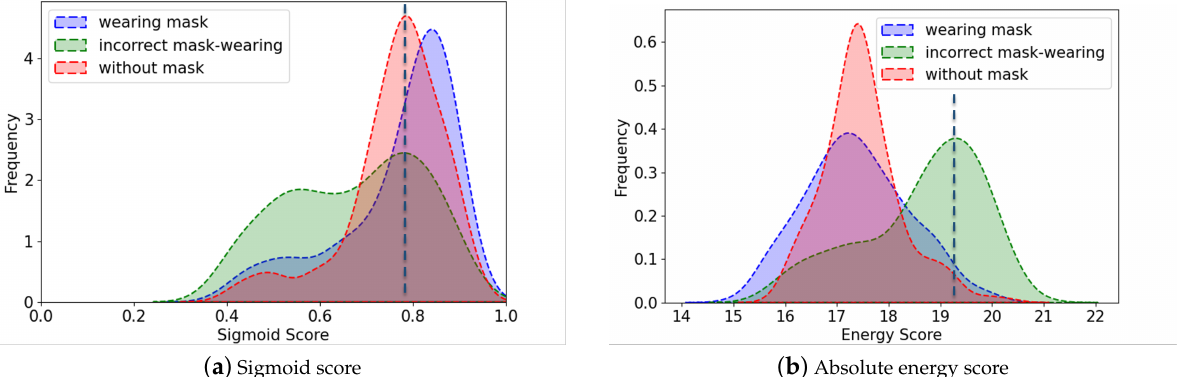
Figure 5. Data distribution: ( a ). The peak of the incorrect mask-wearing which is at around S = 0.8, almost overlaps the peaks of both wearing mask and without mask in ID, although the class has a large proportion of values in the 0.2–0.7 range. ( b ). the values obtained by the OOD-Mask are all negative numbers. In order to compare with the sigmoid score, we take the absolute value of the energy score. the spiky distribution of the incorrect mask-wearing, at absolute energy score | E | = 19.3, is completely separated from wearing mask and without mask, at | E | =